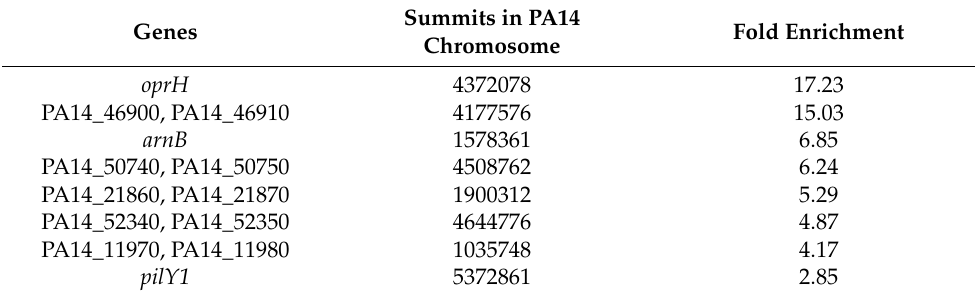
Table 1. Potential PhoP regulated genes identified via